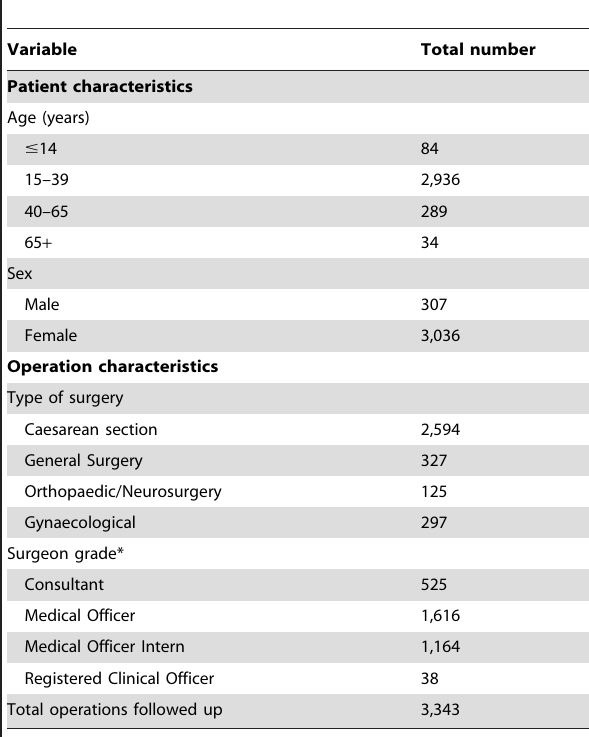
Table 1. Surgical patients in SSI surveillance between August 2010 and November